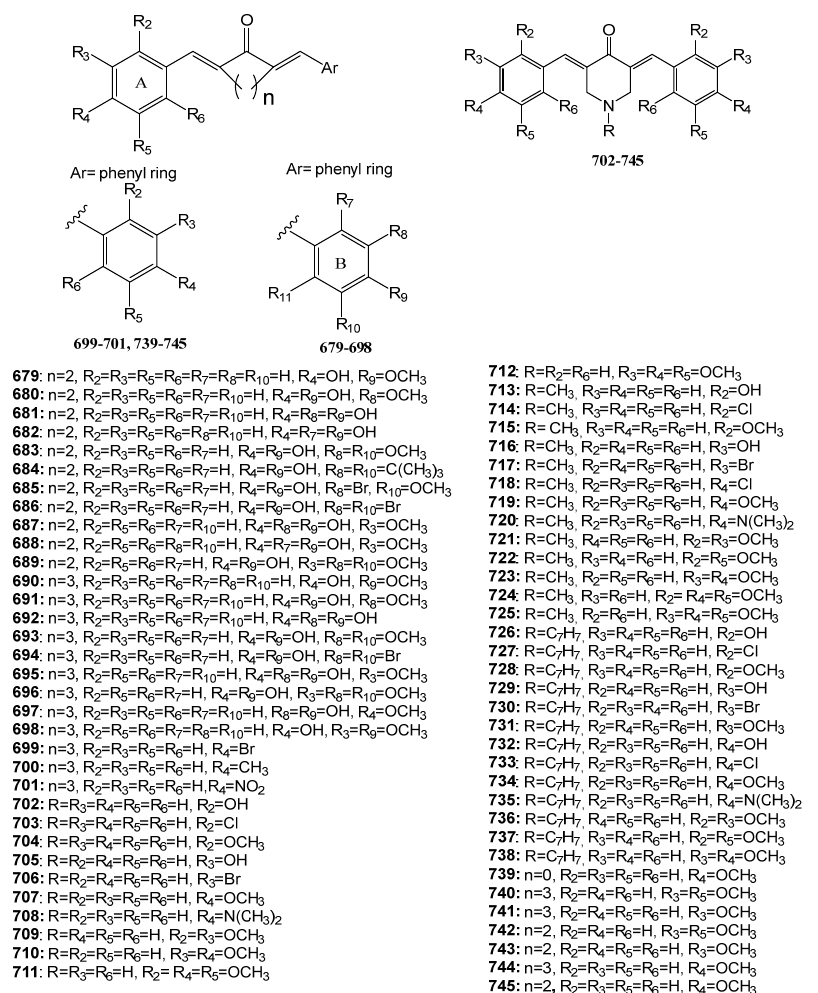
Figure 18. Diarylpentanoids described for their ability to interfere with several proteins.